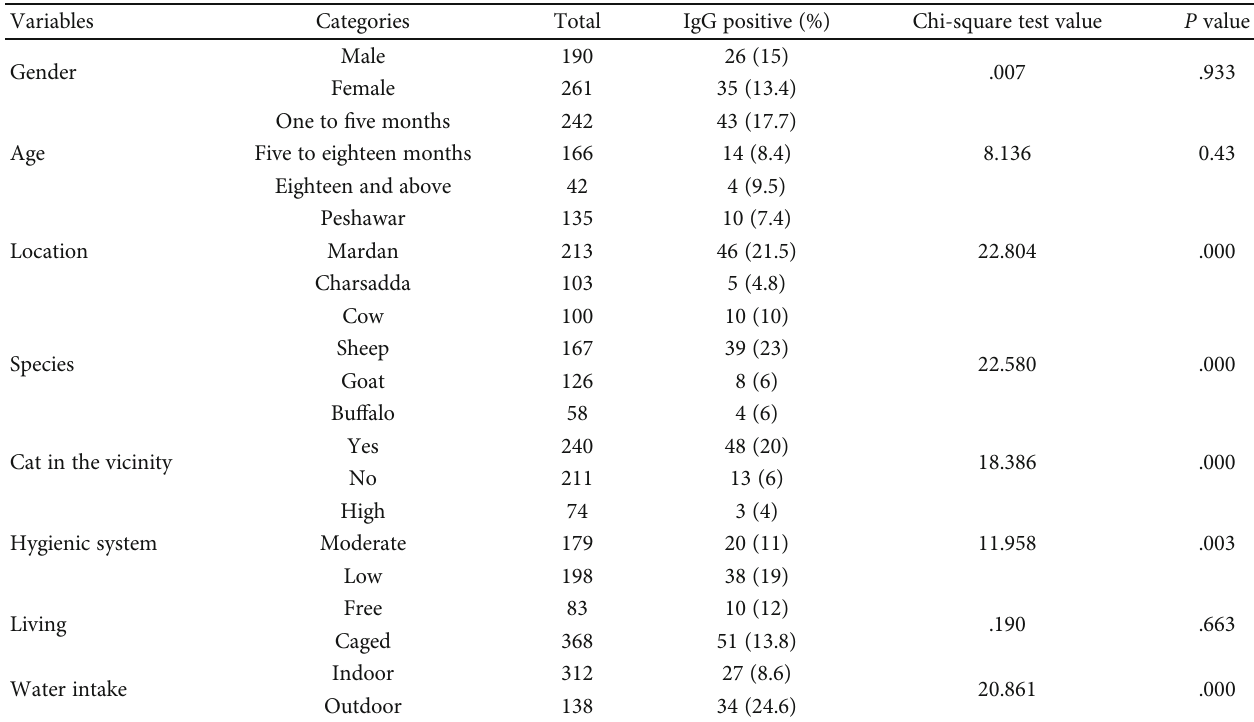
Table 3: Possible risk factors associated with higher IgG antibodies of Toxoplasma gondii prevalence in ruminants using chi-square analysis.